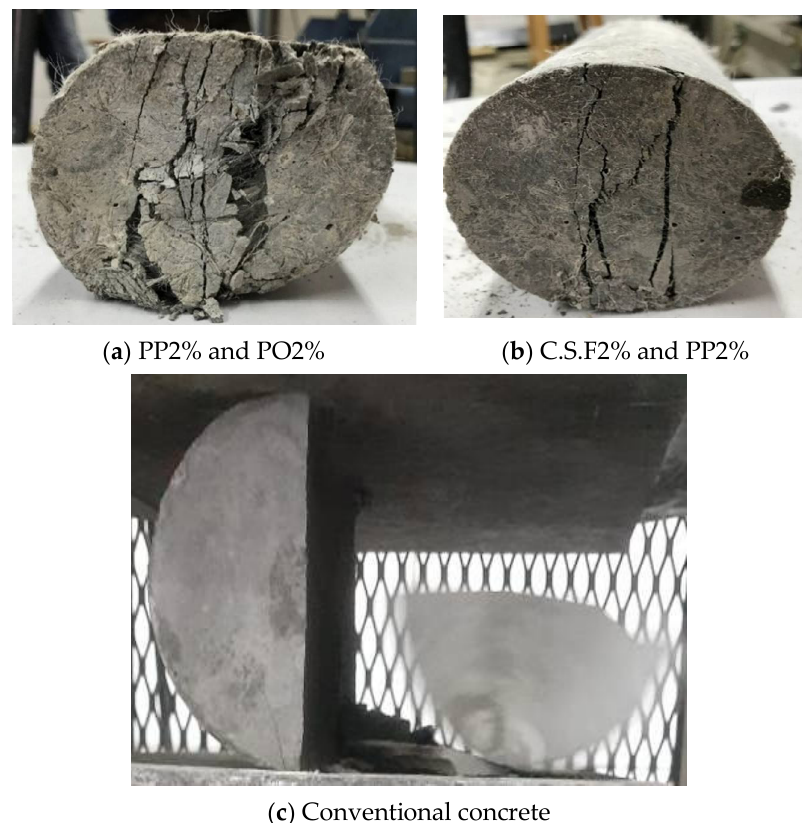
Figure 6. Mode of failure in splitting tensile strength test.